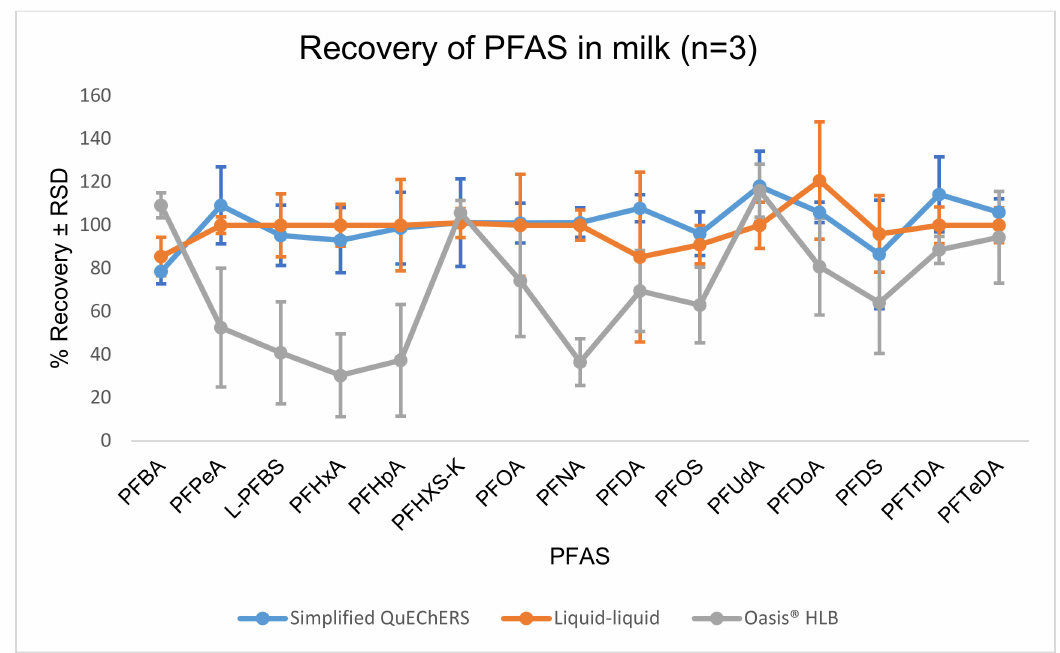
Figure 3. Recovery ( n = 3) of PFAS in milk using the simplified QuEChERS, liquid–liquid and Oasis HLB SPE